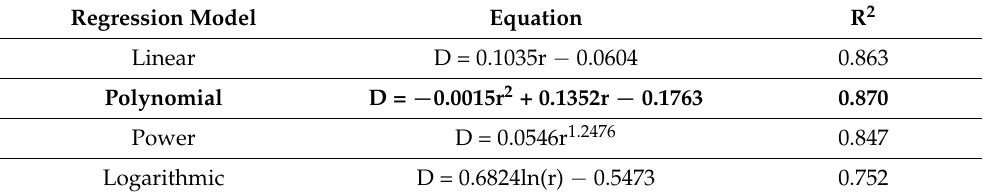
Table 2. The equation and R 2 of each regression method for estimating Diameter Breast Height.